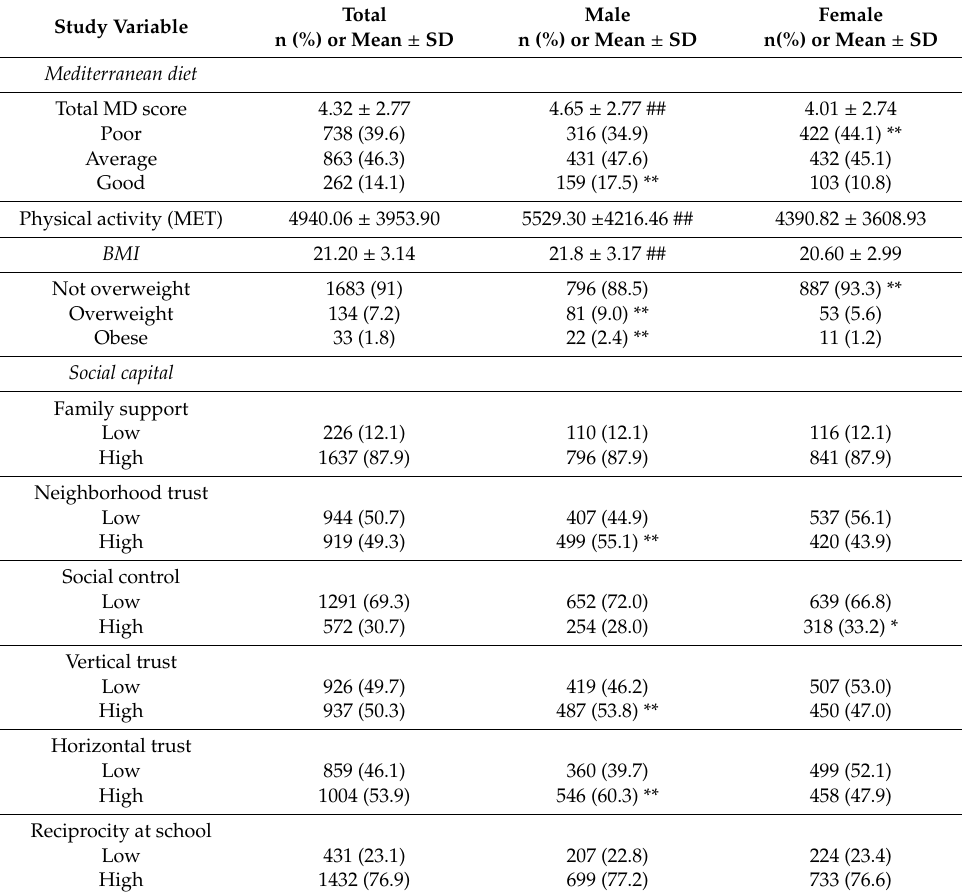
Table 1. Descriptive statistics and comparison of study variables between genders (n =